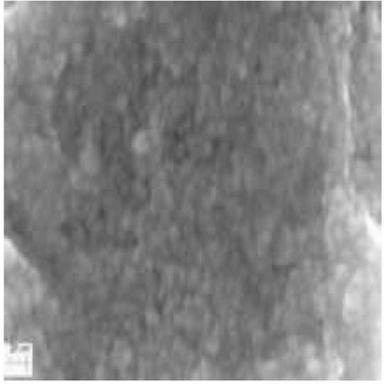
SEM of NiO thin film annealed at 500 ◦C.